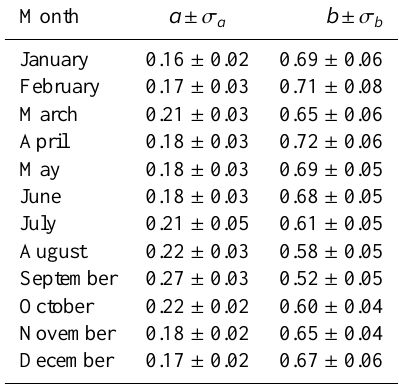
Table 1. Monthly a , b coe ffi cients in Eq. (1) and corresponding standard errors based on the 31 Italian Air Force station with both global radiation and sunshine duration